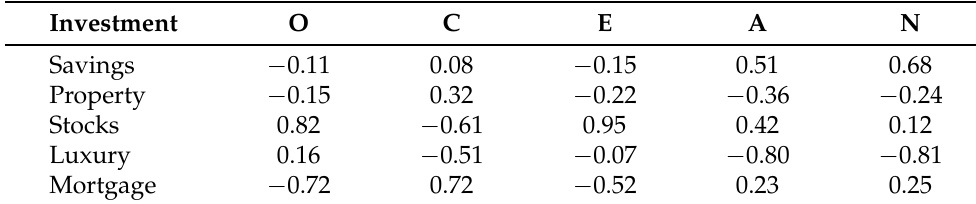
Table 3. Coefficients relating asset risk, expected return, liquidity, capital requirement, and novelty to prototypical personality traits: openness (O), conscientiousness (C), extraversion (E), agreeableness (A), and neuroticism (N). The values are in the range [ − 1,1 ]